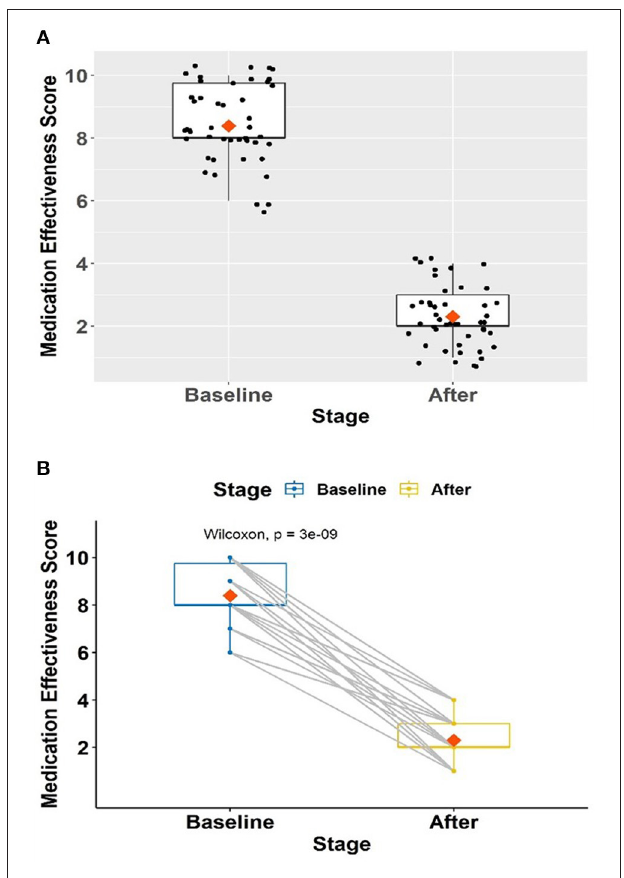
FIGURE 5 | (A,B) Correlation between genetic mutation scores and treatment effectiveness scores in all patients (A) n = 84 and in those with complete follow-up (B) n =